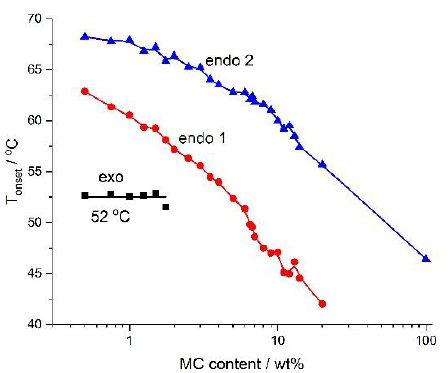
Figure 5. Phase diagram for various concentrations of MC constructed using the onset temperature.